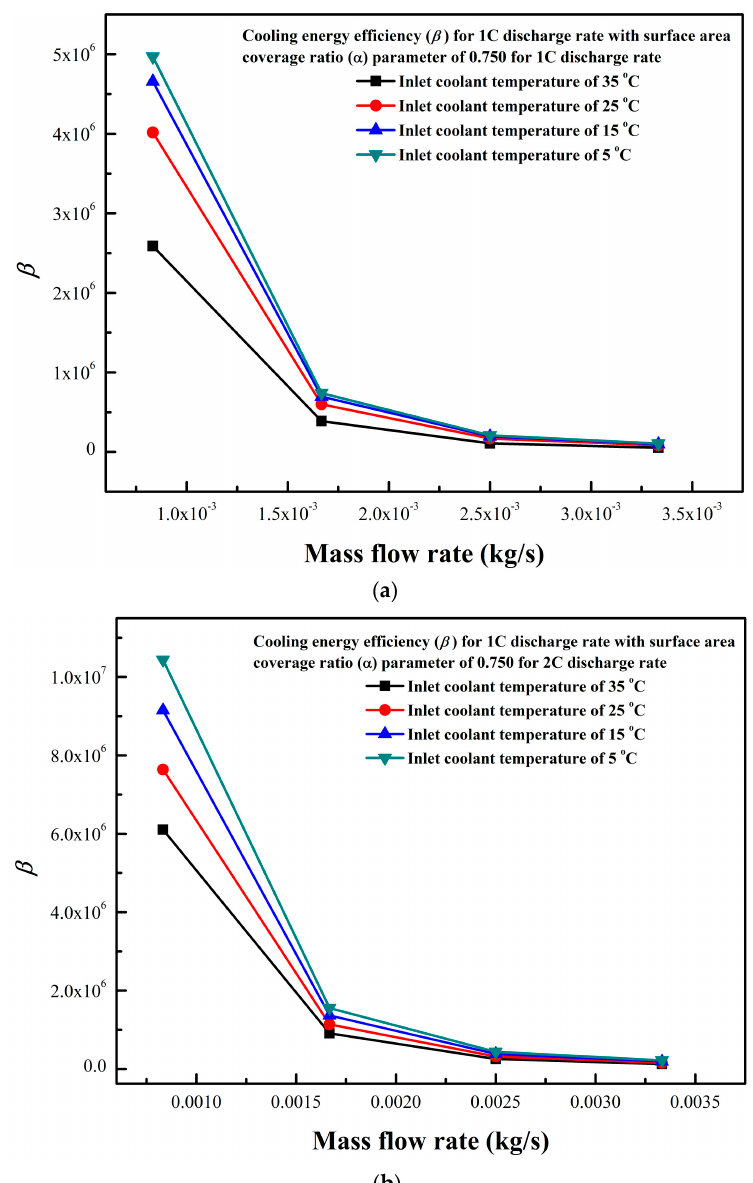
Figure 8. Cooling energy efficiency ( β ) of 20 Ah lithium-ion pouch cell with surface area coverage ratio ( α ) parameter of 0.750: ( a ) 1C; ( b ) 2C.